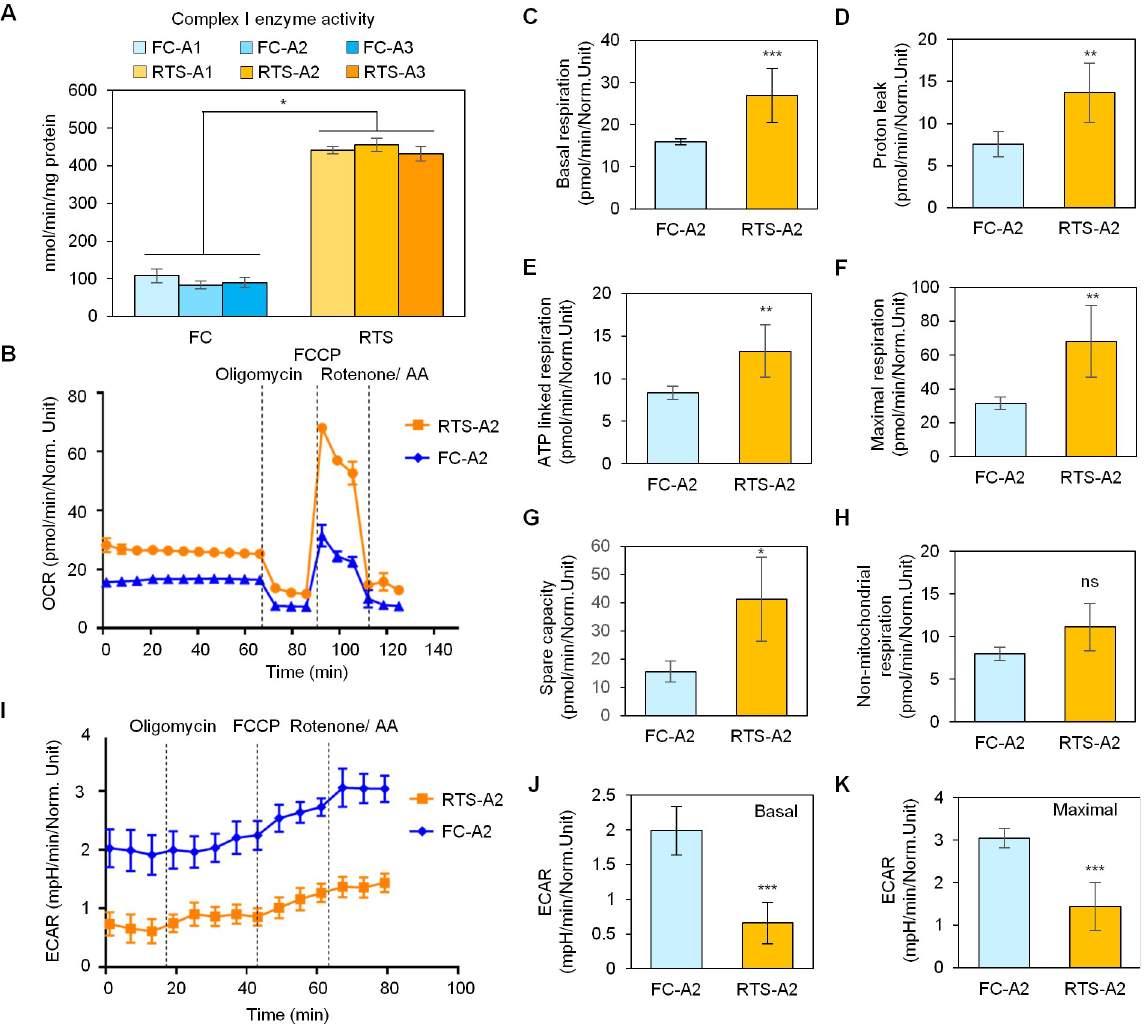
Fig 4. Metabolic differences between RTS and FC osteoblasts demonstrate the role of OXPHOS in increasing ATP production in RTS osteoblasts. (A) Enzyme activity of complex I is increased in RTS osteoblasts. n = 3 biological replicates. (B) Seahorse assays indicate increased oxygen consumption rate, a measure of OXPHOS, in RTS osteoblasts. n = 3 biological replicates. (C-H) Individual calculations of basal respiration (C), proton leak (D), ATP-linked respiration (E), maximal respiration (F), and spare capacity (G) in RTS osteoblasts as measured by seahorse assay, all of which are significantly upregulated. Non-mitochondrial respiration (H), which is not attributed to OXPHOS, is comparable between RTS and parental osteoblasts. n = 3 biological replicates. (I) Seahorse assays show decreased extracellular acidification rate, a measure of glycolysis, in RTS osteoblasts. n = 3 biological replicates. (J-K) Significantly decreased basal extracellular acidification rate (J) and maximal acidification rate (K) in RTS osteoblasts indicate RTS osteoblast reliance on OXPHOS for ATP production. n = 3 biological